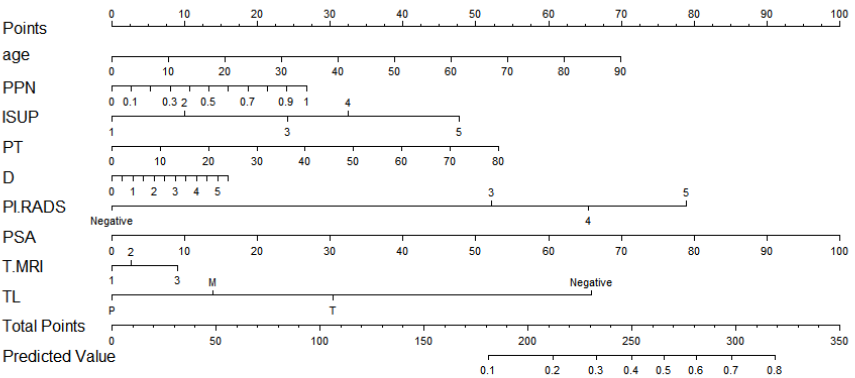
Figure 2. The nomogram.